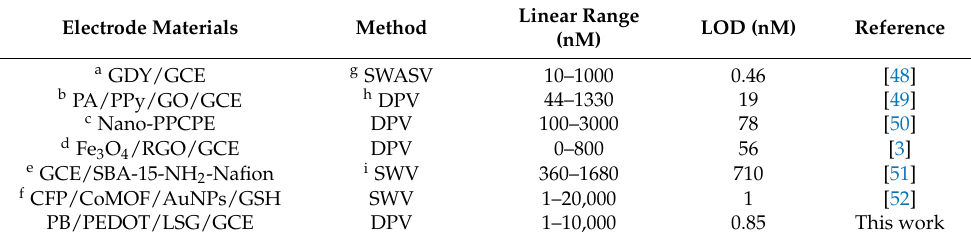
Figure 4. ( a ) DPV curves of Cd 2+ with different concentrations (form 1 nM to 10 µ M) on PB-PEDOT/LSG/GCE; ( b ) magnifying DPV curves of Cd 2+ with low concentrations (form 1 nM to 10 nM); ( c ) and ( d ) corresponding calibration curves for current versus Cd 2+ concentration. Table 1. Comparison of Cd 2+ sensing using proposed method with some previous reports.